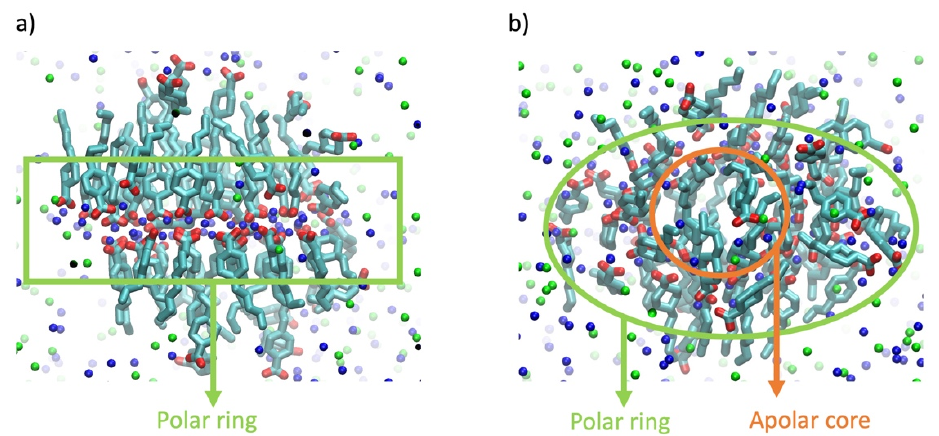
Figure 8. Structure of the aggregate found for the NA mixture at high salinity solution (NaCl 90 g/L). Blue spheres represent Na + ions, green spheres Cl − anions, and red and cyan spheres NA oxygen and carbon atoms. ( a ) Side view, ( b ) top view.